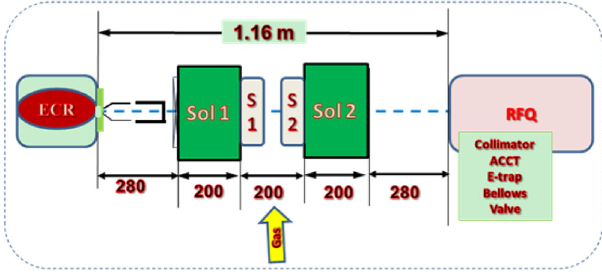
FIG. 1. The schematic view of helium injector.